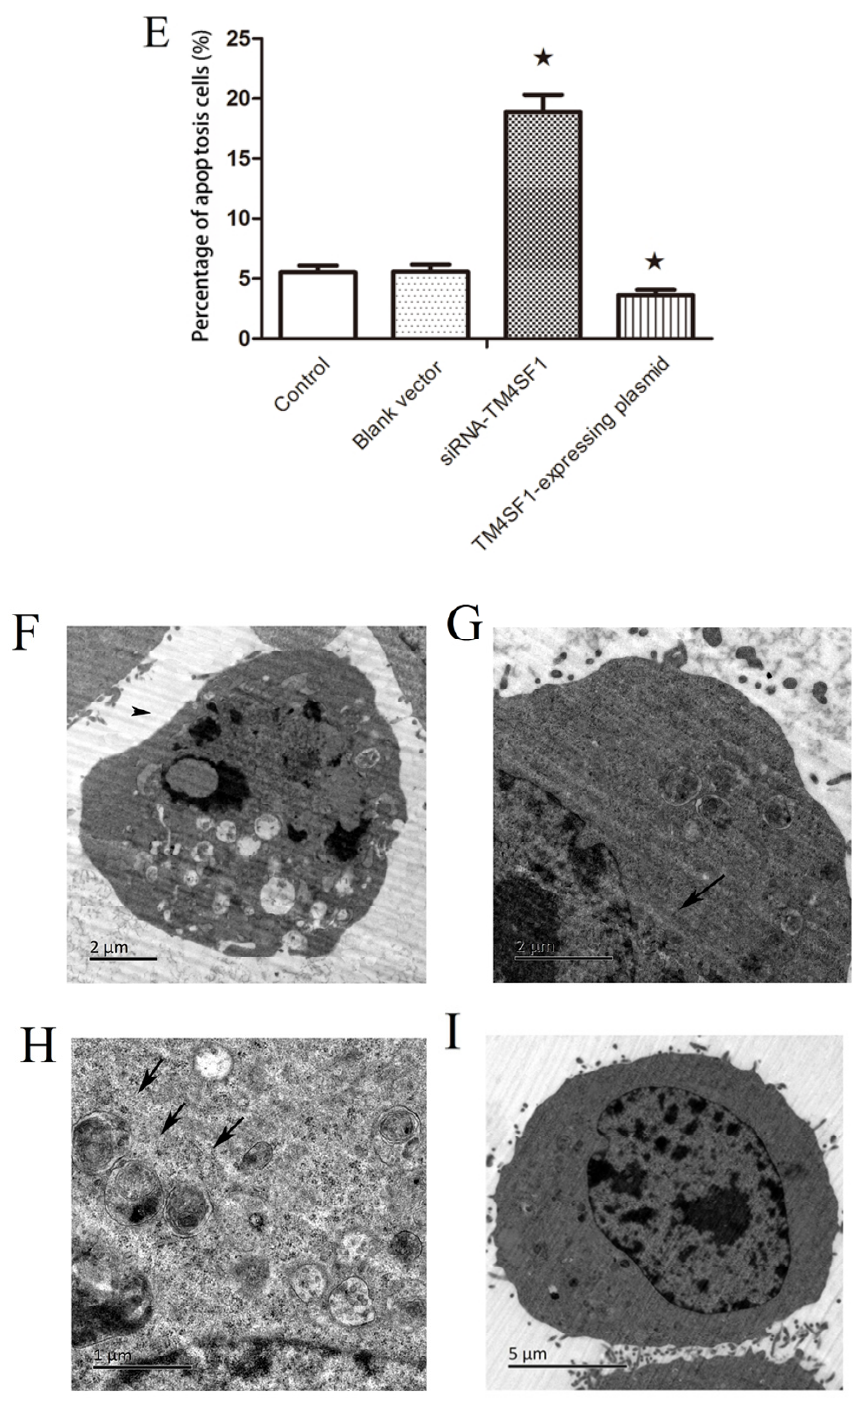
Figure 1. TM4SF1 gene knockdown led to increased apoptosis and autophagy of HepG2 cells while TM4SF1 overexpression reduced the apoptosis of cells. HepG2 cells were not transfected ( A ); transfected with blank vectors ( B ); transfected with siRNA ‐ TM4SF1 ( C ); or transfected with TM4SF1 ‐ expressing plasmids ( D ) and then harvested and processed for measurement of apoptosis by flow cytometry ( E ). Transmission electron microscopy was used to determine apoptosis and autophagy of HepG2 cells without transfection ( F ); transfected with blank vectors ( G ); transfected with siRNA ‐ TM4SF1 ( H ); or transfected with TM4SF1 ‐ expressing plasmids ( I ). Arrowhead, karyokinesis; Arrow, autophagosomes. Experiments were performed 3 times and similar findings were observed. ★ p < 0.01 vs. non ‐ transfected HepG2 cells.